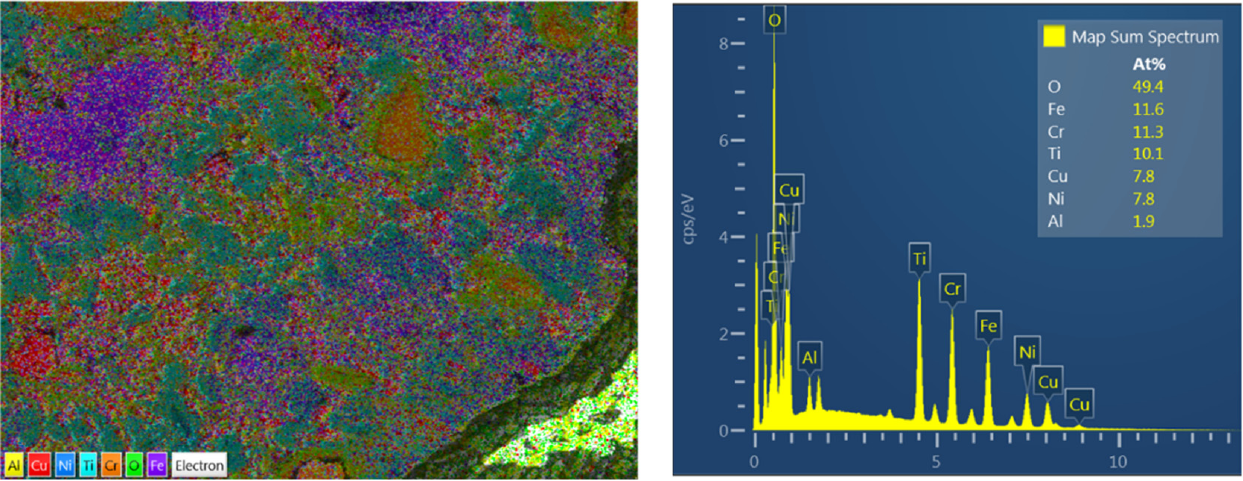
Figure 5. Elemental mapping of CrCuFeNiTiAl 0.01 sample.